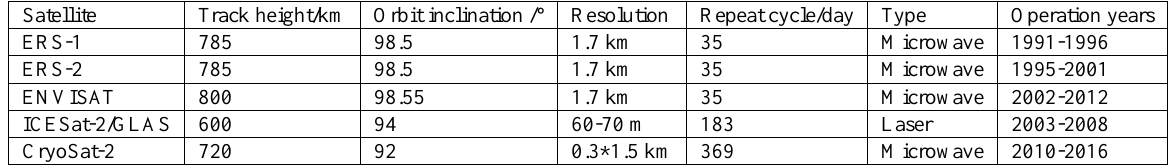
Table 2. Parameters of altimetry satellite